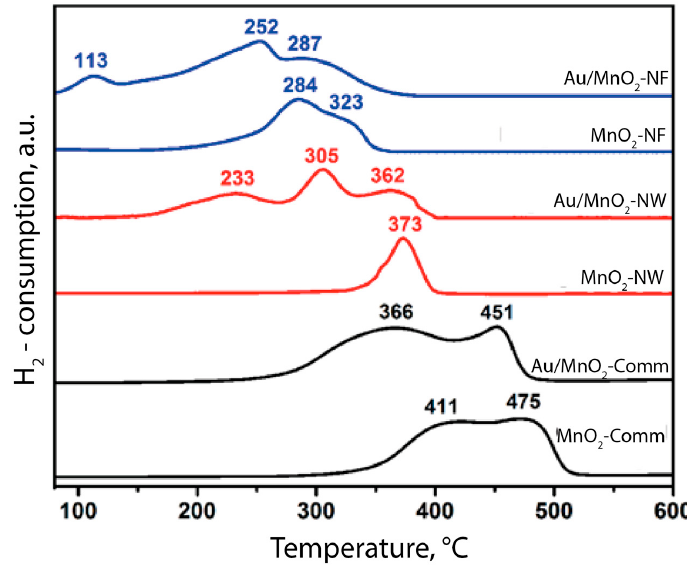
Figure 2. Temperature programmed reduction (TPR) profiles for MnO 2 nanoflowers (in blue), nanowires (in red), and commercial MnO 2 (in black) before and after the deposition of Au nanoparticles on their surfaces.